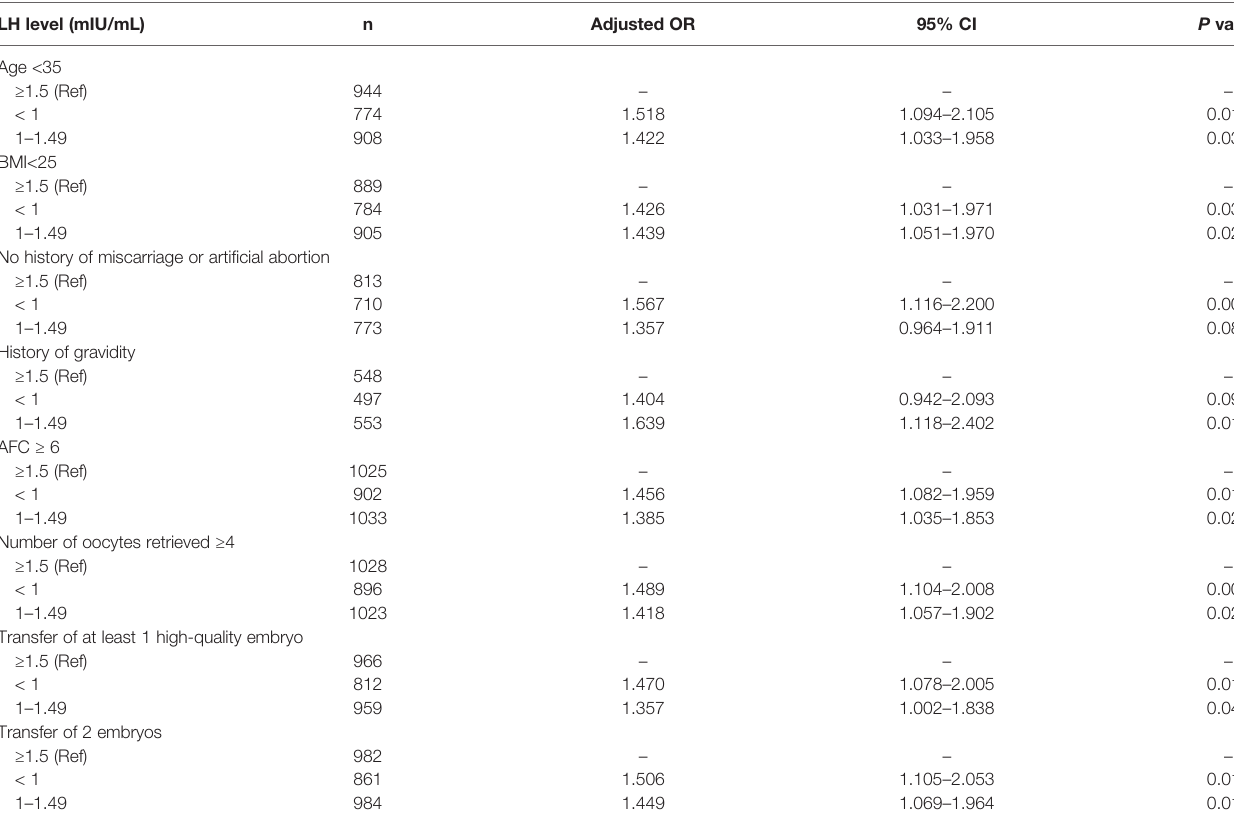
TABLE 4 | Subgroup analysis of LH in early pregnancy loss in fresh ET